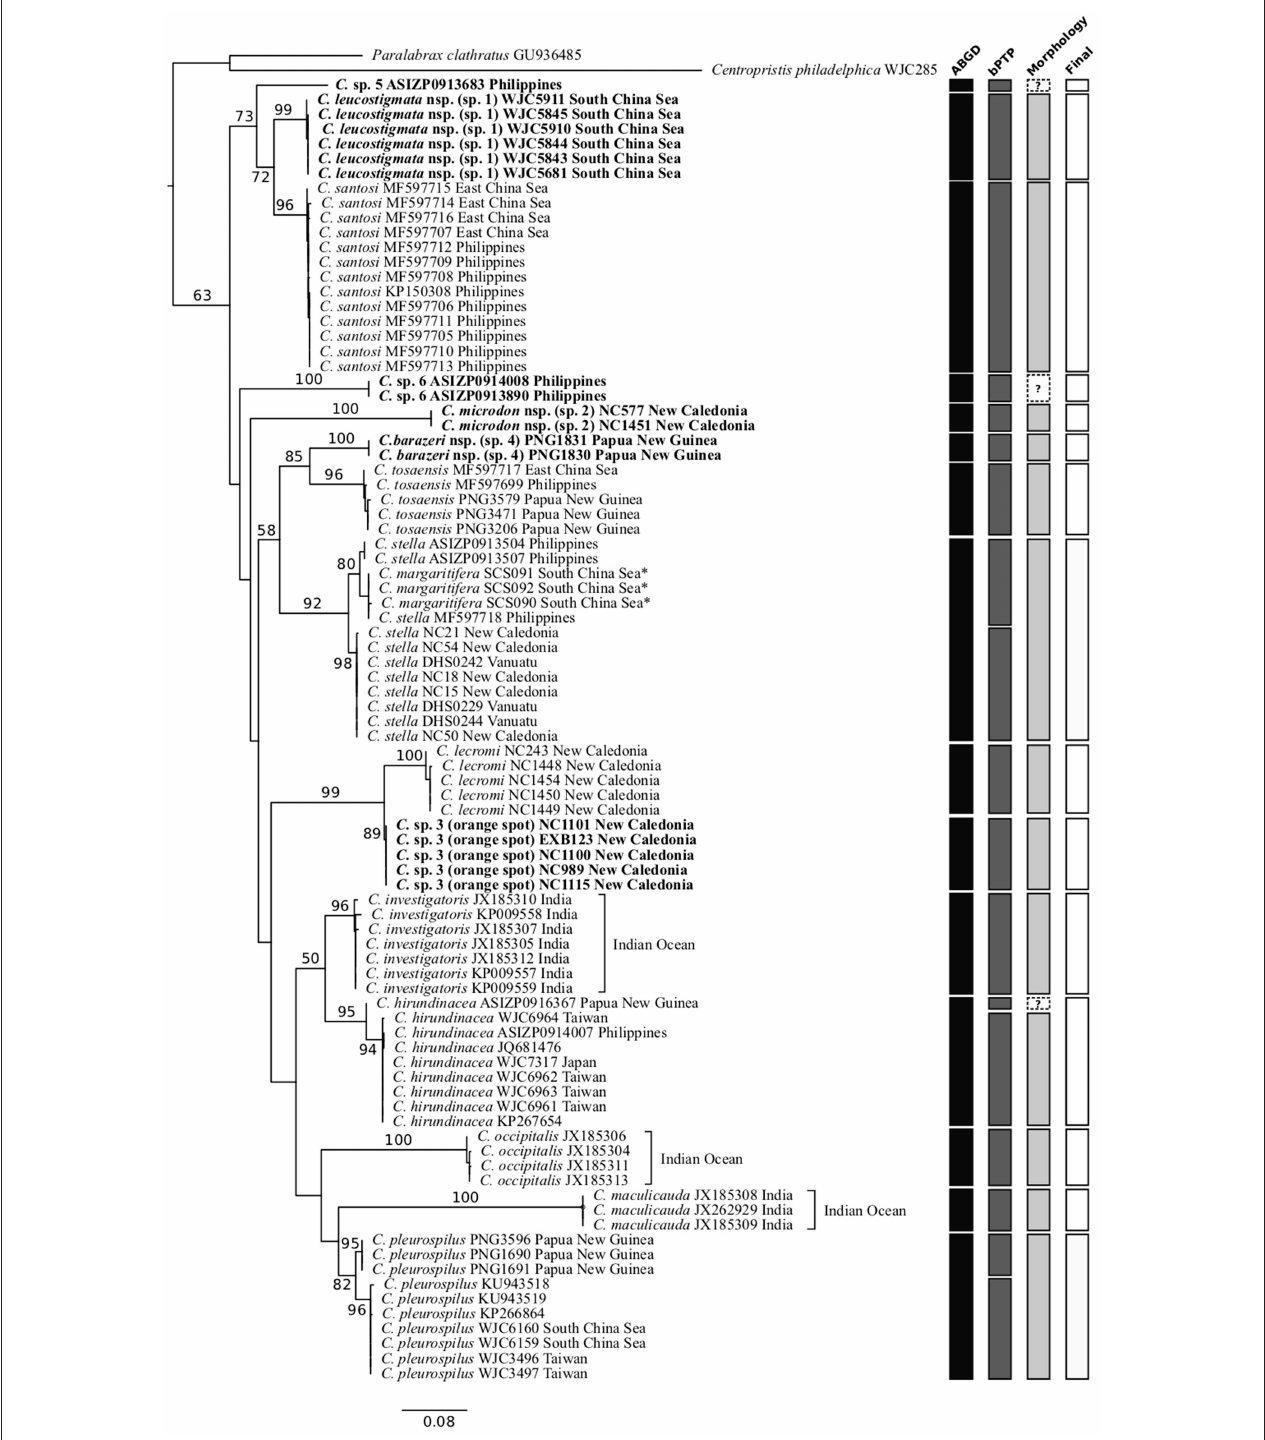
FIGURE 2 | Phylogenetic tree of Chelidoperca species inferred by the partitioned maximum-likelihood method with GTR + G nucleotide substitution model based on the COI gene dataset, species delimitation analyses, and additional criteria (see materials and methods). Branch lengths are proportional to inferred nucleotide substitutions. Numbers at nodes represent bootstrap values in percentages. Values < 50% are not shown. Taxa names in bold indicate new or potential new species discovered in this study. *indicates probable misidentified samples. The tree is rooted with two known species from the Serraninae. A summary of determined OTUs (vertical bars) is presented on the right side of the phylogenetic